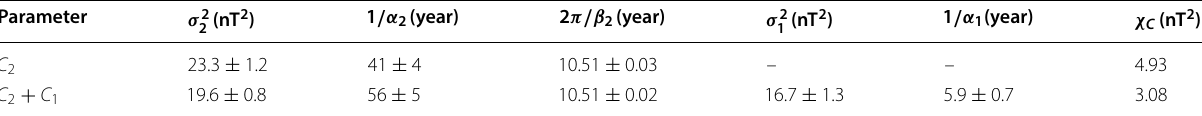
Table 3 Parameters of the correlation functions C 2 (τ) and C 2 (τ) + C 1 (τ) fitted to C